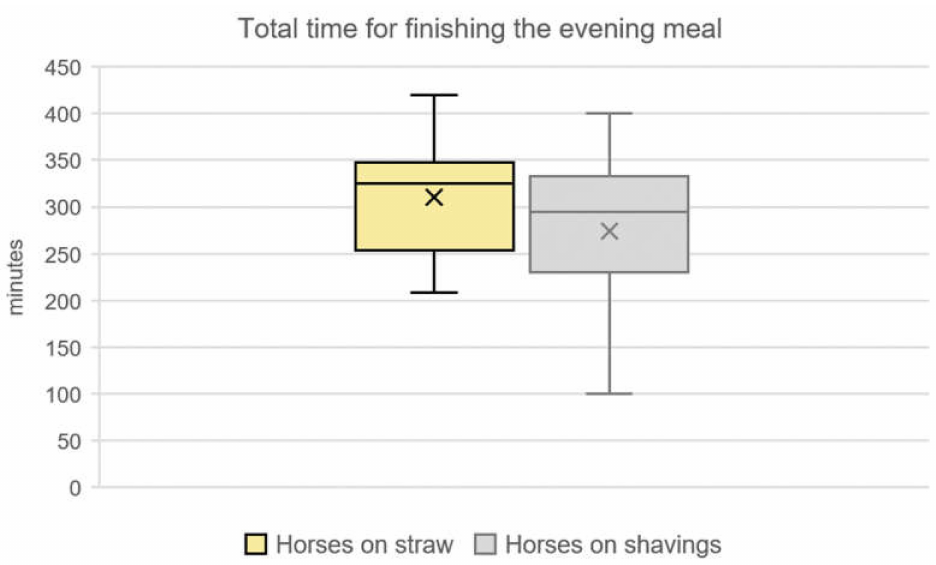
Figure 1. Total time for finishing the evening meal of horses on straw in comparison to horses on shavings, which finished their evening meal within the observation period (79.69%; n = 51 out of 64 horses; median: 325 min of n = 17 horses on straw; median: 307 min of n = 34 horses on shavings, p =